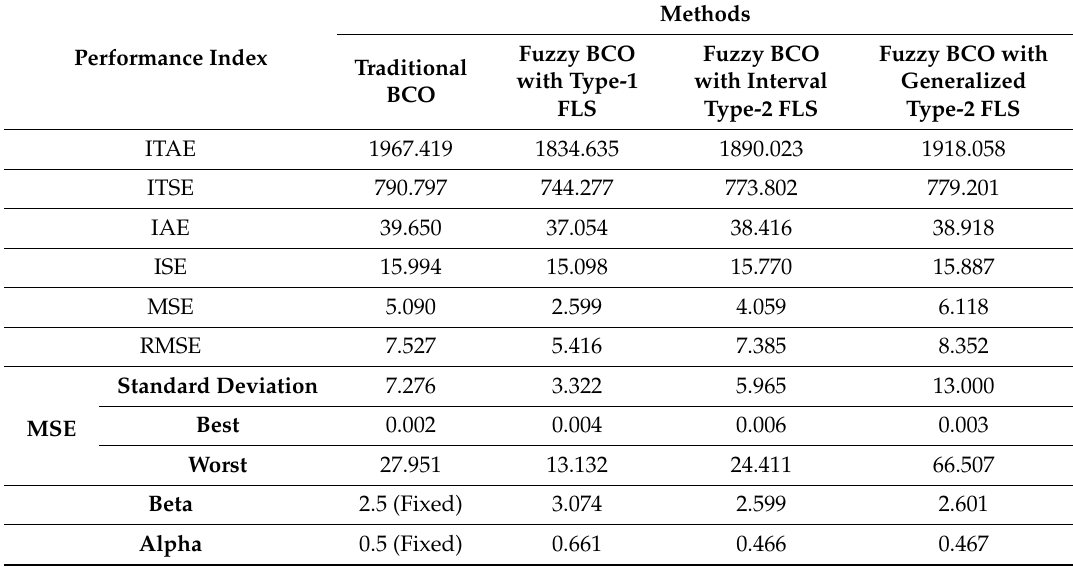
Table 6. Simulation results without perturbation in the model.